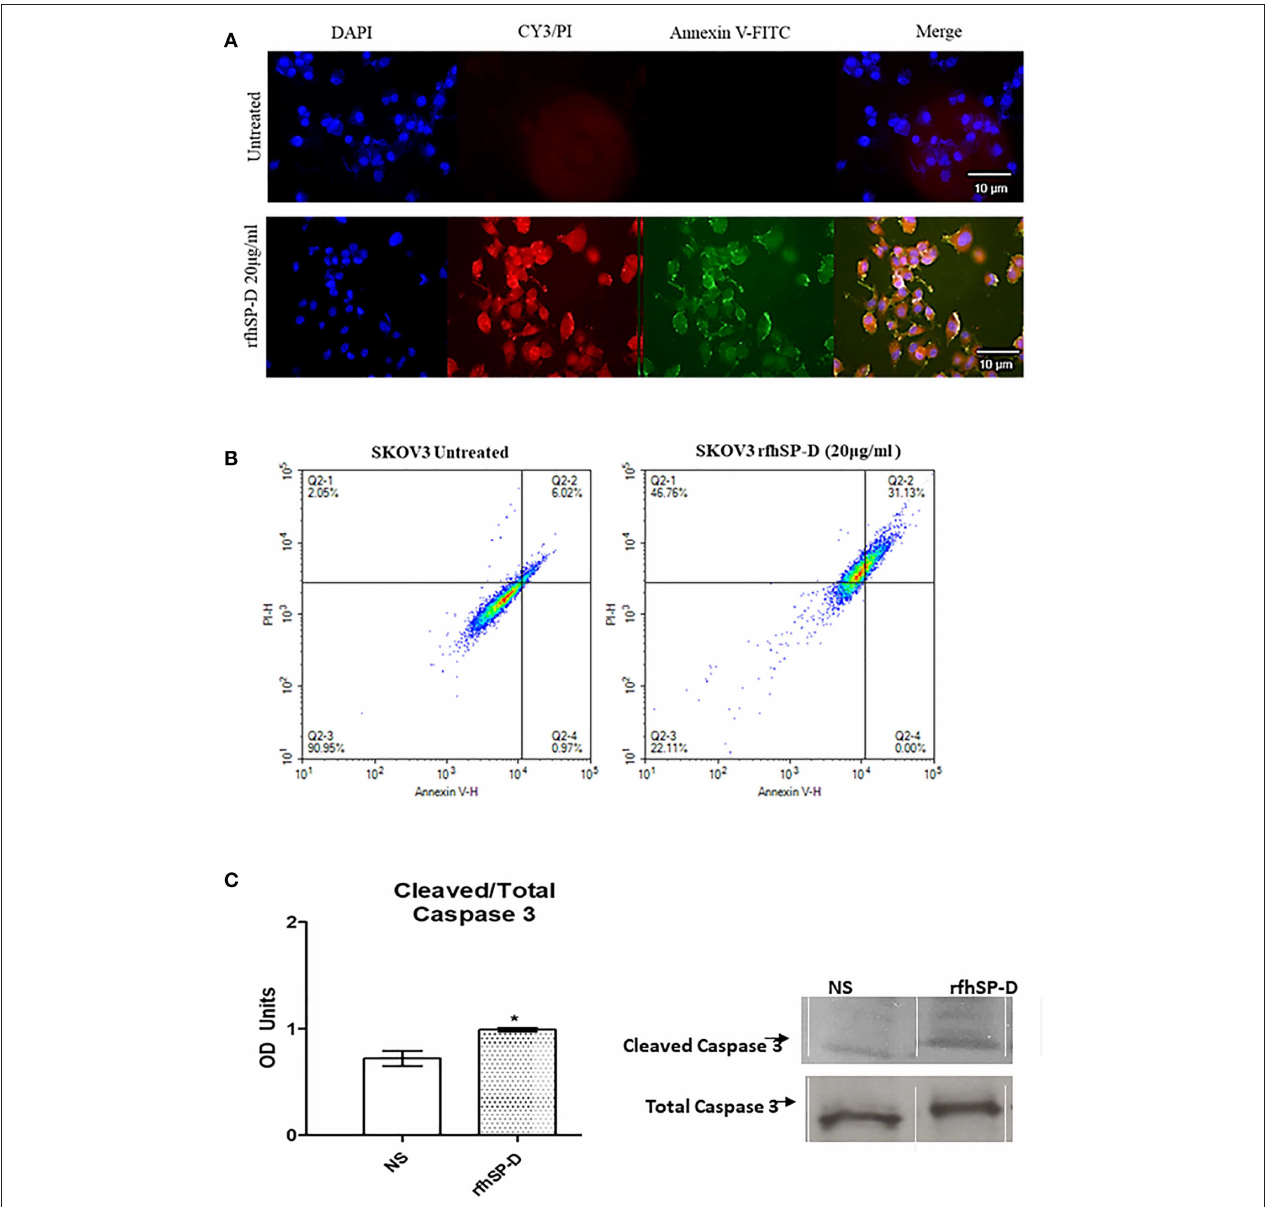
FIGURE 7 | Fluorescence microscopy to analyze apoptosis in SKOV3 cells treated with rfhSP-D for 48h. Apoptosis was analyzed using an annexin V/propidium iodide (PI) staining kit (A) . The cell membrane was positively stained for annexin V and the DNA staining is visible in the treated cells indicating that the cells underwent apoptosis and PI was taken in which stained the DNA of apoptotic cells. No such staining was seen in the untreated cells. The nucleus was stained with Hoechst for both treated and untreated cells (A) . Quantitative analysis of apoptosis using Flow Cytometer (B) . SKOV3 cells were treated with rfhSP-D 48h and apoptosis was analyzed using annexin V with PI kit. Cells were acquired and plotted for both annexin V/FITC, which showed a shift in the fluorescence intensity of in treated cells (B) . Effects of rfhSP-D on caspase 3 (C) . Scanning densitometry of protein expression of cleaved over total caspase 3 in SKOV3 cells treated with rfhSP-D ± SD at 48h which were acquired from the western blotting analysis (C) . Cleaved Caspase 3 over total ratio was significantly increased after 48h 20 µ g/ml. * p < 0.05.